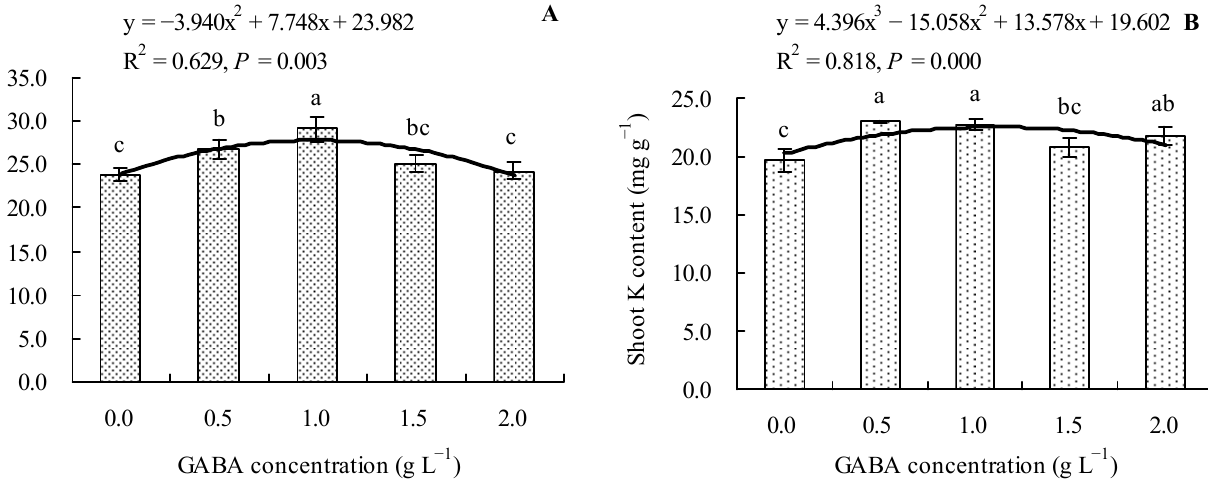
Figure 3. Total P content in loquat seedlings under the influence of gamma amino butyric acid. ( A ): Root P content; ( B ): shoot P content. Values are means ( ± SD) of three replicates. Different lowercase letters indicate significant differences among the treatments (Duncan’s Multiple Range Test, P < 0.05). GABA = gamma amino butyric acid.